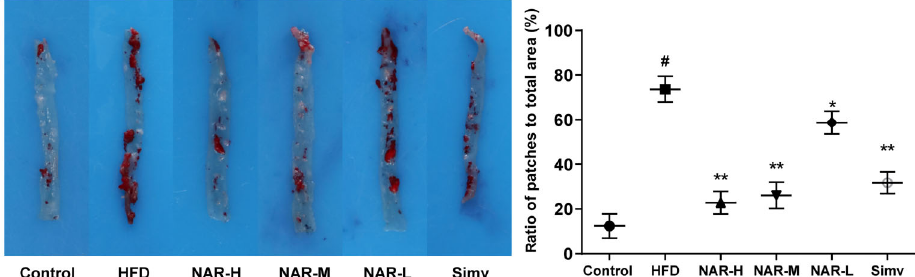
Figure 4. Photograph and graph showing that NAR reduced the plaque area in HFD-induced atherosclerosis ApoE – / – mice. Data are reported as mean ± SD. # P o 0.01, *P o 0.05, compared to the control group; **P o 0.01, compared to the HFD group; n=5 (ANOVA). NAR: naringenin: high (H), medium (M), low (L); HFD: high-fat-diet; ApoE – / – : apolipoprotein E-knockout; Simv: simvastatin.